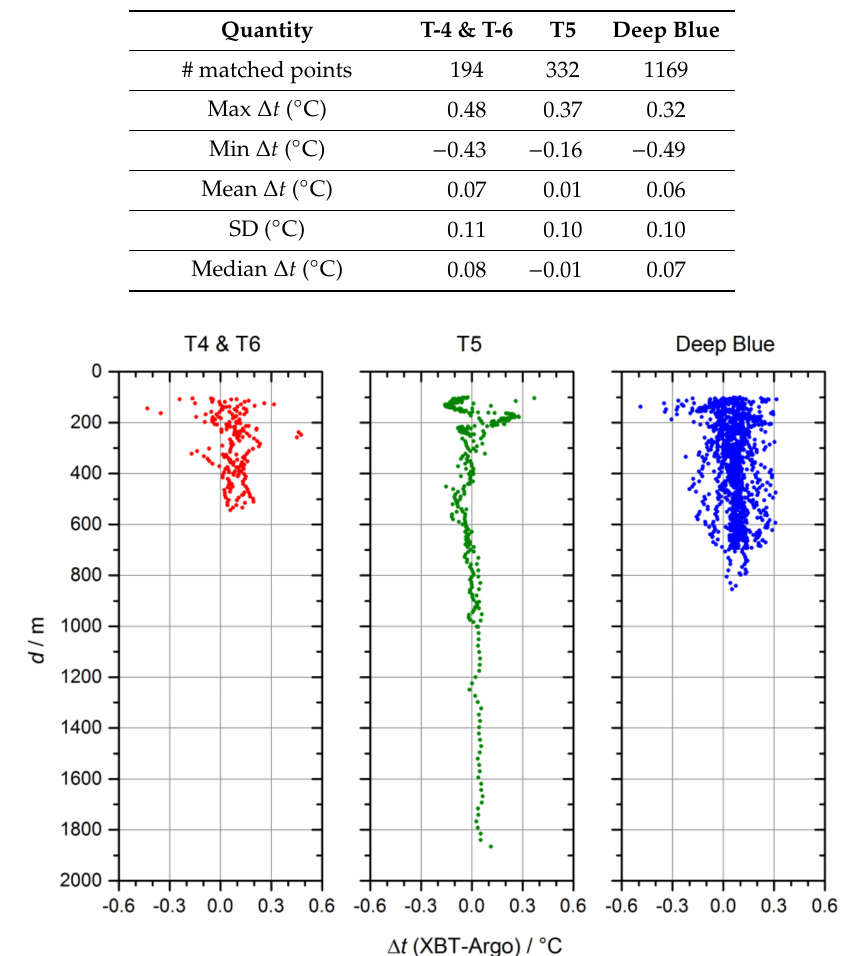
Table 7. ∆ t ( XBT-Argo) for each XBT type involved. Depth: 100 m-bottom ( ± 1 day).